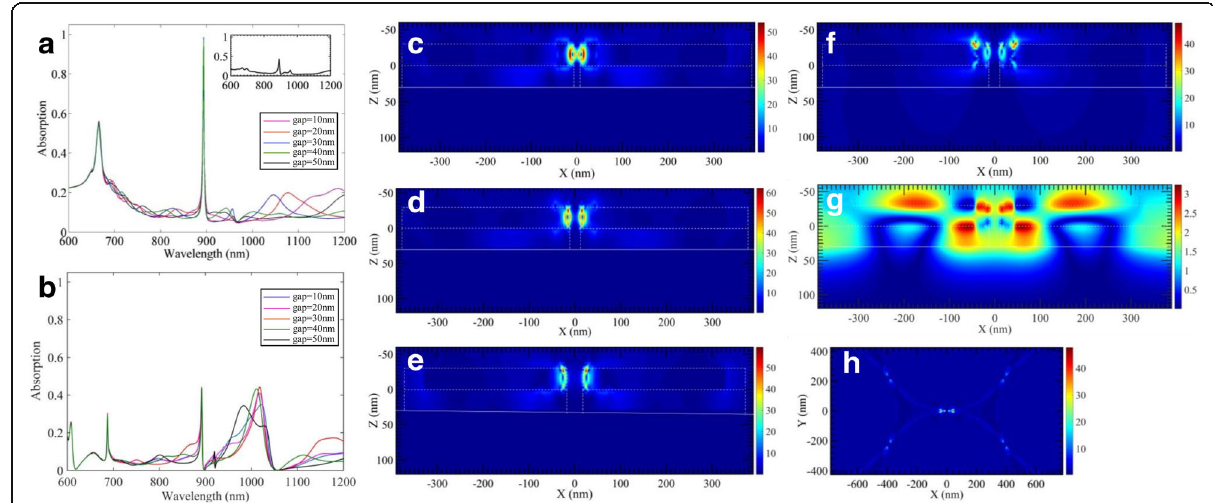
Fig. 2 Absorption spectrum varies with the gap sizes between adjacent tips of triangles increasing of MIM structure array ( a ) and MII structure array ( b ). The inset at the top-right corner of a is absorption spectrum of isolated MIM structure. c – e Electric field |E| distribution of xoz plane ( y = 0 nm) of MIM structure array models with gap sizes of 20 nm, 30 nm, 50 nm, respectively. f |E| distribution of xoz plane ( y = 0 nm) of MII structure array model with gap size 30 nm. g |H| distribution of xoz plane ( y = 0 nm) of MIM structure array model with gap size of 30 nm. h |E| distribution of xoy plane ( z = − 30 nm) of MIM structure array model with gap size of 30